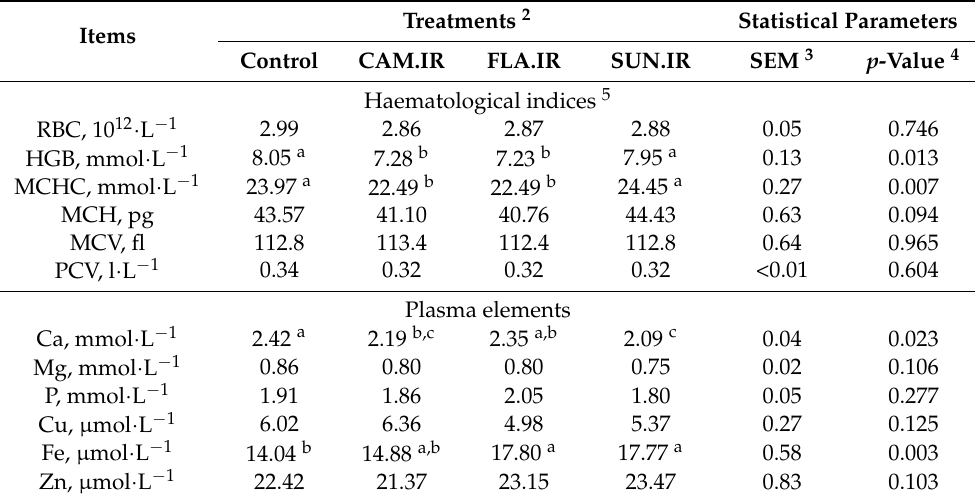
Table 6. Effect of dietary inclusion of full-fat seeds on haematological indices and content of elements in broiler chicken plasma 1 . Treatments 2 Statistical Parameters Items Control CAM.IR